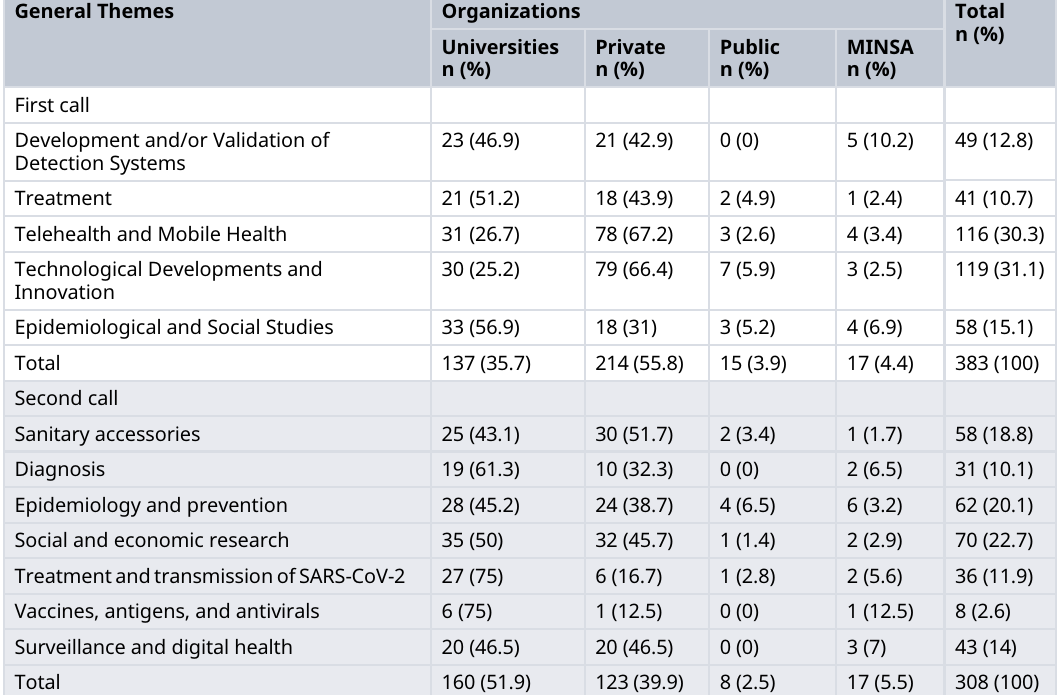
Table 2. Projects according to organizations. Total of participating entities according to themes of the Special Projects: Response to COVID-19 contest for both calls. Data in n